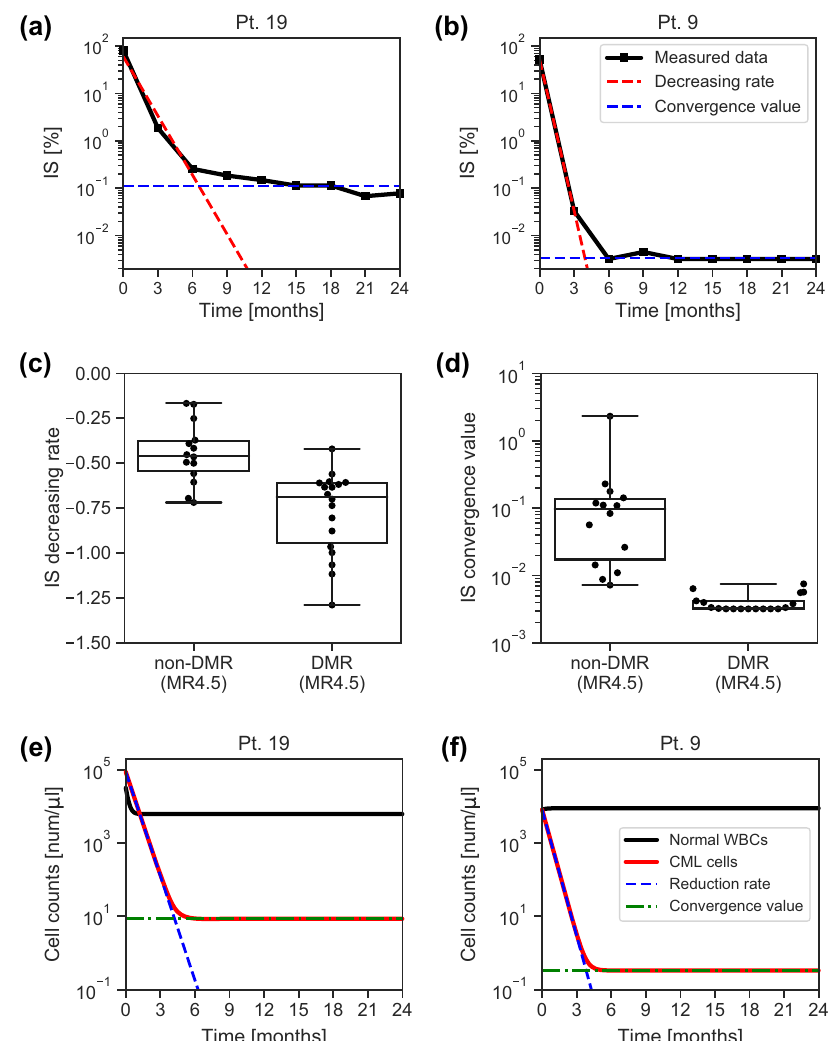
Fig. 2 Key features for DMR prediction: the decreasing rate and convergence value of IS, and the reduction rate and convergence value of CML cells. a , b The time series of IS are plotted in ( a ) for a non-DMR patient (patient # 19) and in ( b ) for a DMR patient (patient # 9). The decreasing rate and convergence value of IS are two key features for DMR prediction. A detailed information of the parameter estimation can be found in Methods. c The distributions of the IS decreasing rate for non-DMR and that for DMR patients were different. d The distributions of the IS convergence value for non-DMR and that for DMR patients were distinct. The de fi nitions of the bars of the boxes, lines, and dots used in the boxplots ( c , d ) are the same as those in Fig. 1. e , f We show the estimated dynamics of normal WBCs and CML cells counts in ( e ) for a non- DMR patient (patient # 19) and in ( f ) for a DMR patient (patient # 9). These fi gures indicate that the reduction rate and convergence value of CML cells play a key role in the distinction between DMR and non-DMR